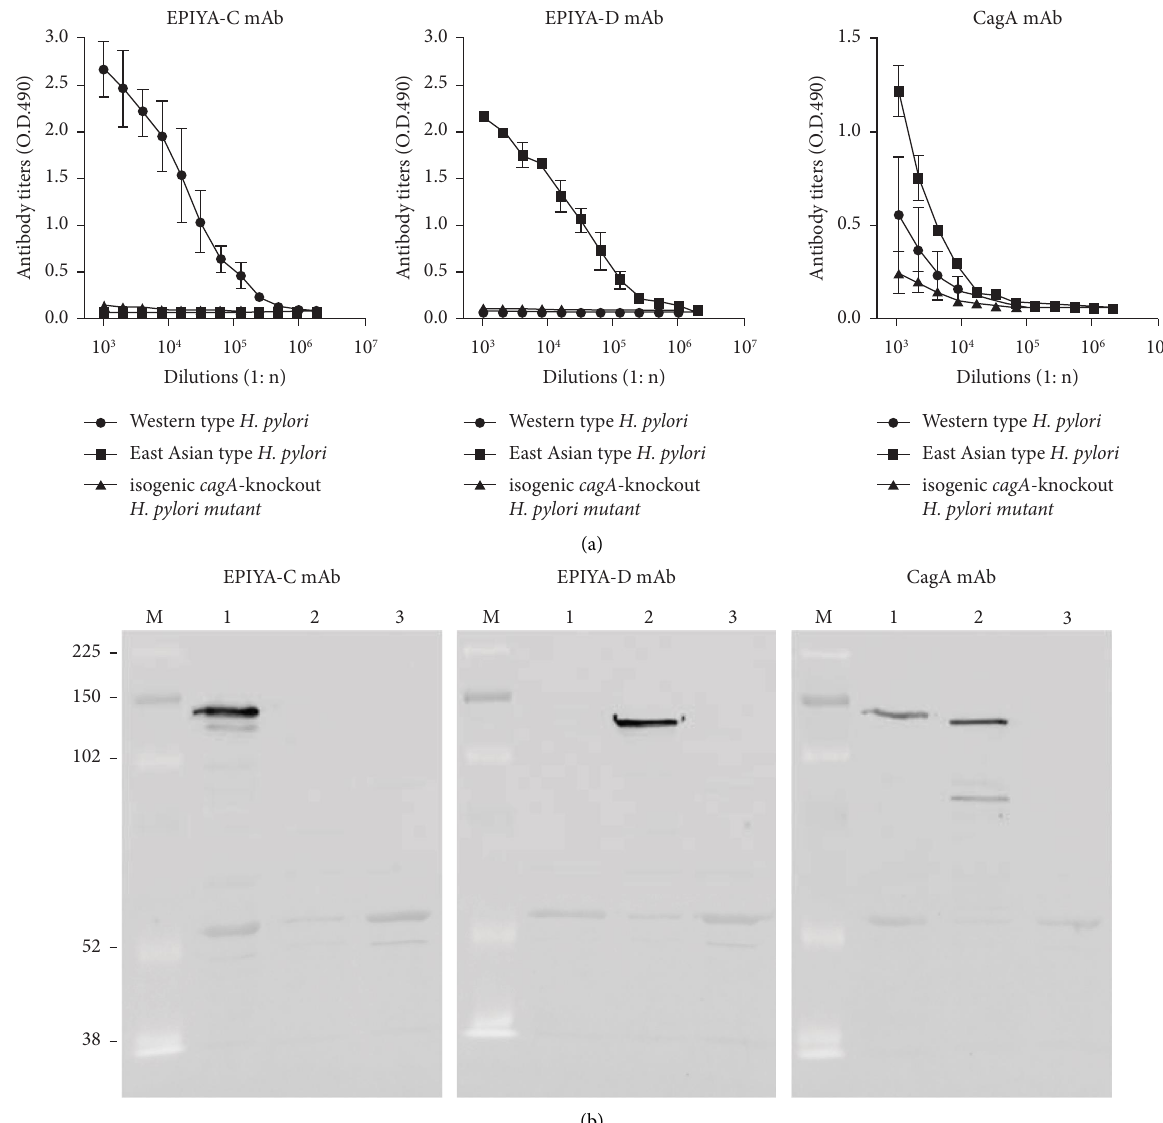
Figure 1: Specifcity of the EPIYA-C and EPIYA-D mAbs by ELISA and Western blotting. Te specifcity of the novel mAbs or the CagA mAb was examined by ELISA (a) and Western blotting (b) using the sonicated whole cell lysate of a Western type H. pylori (ATCC 43504: lane 1), an East Asian type H. pylori (HpLN-4: lane 2), or an isogenic cagA -knockout H. pylori mutant (ATCC 43504 Δ cagA : lane 3). Among the 3 strains of H. pylori , the EPIYA-C mAb was specifc to the Western type and the EPIYA-C mAb was specifc to the East Asian type, while the CagA mAb reacted with both the Western and East Asian type CagA protein detected by the novel EPIYA-C or EPIYA-D mAb. Error bars indicate standard deviation of 3 identical wells. (M) Molecular size marker